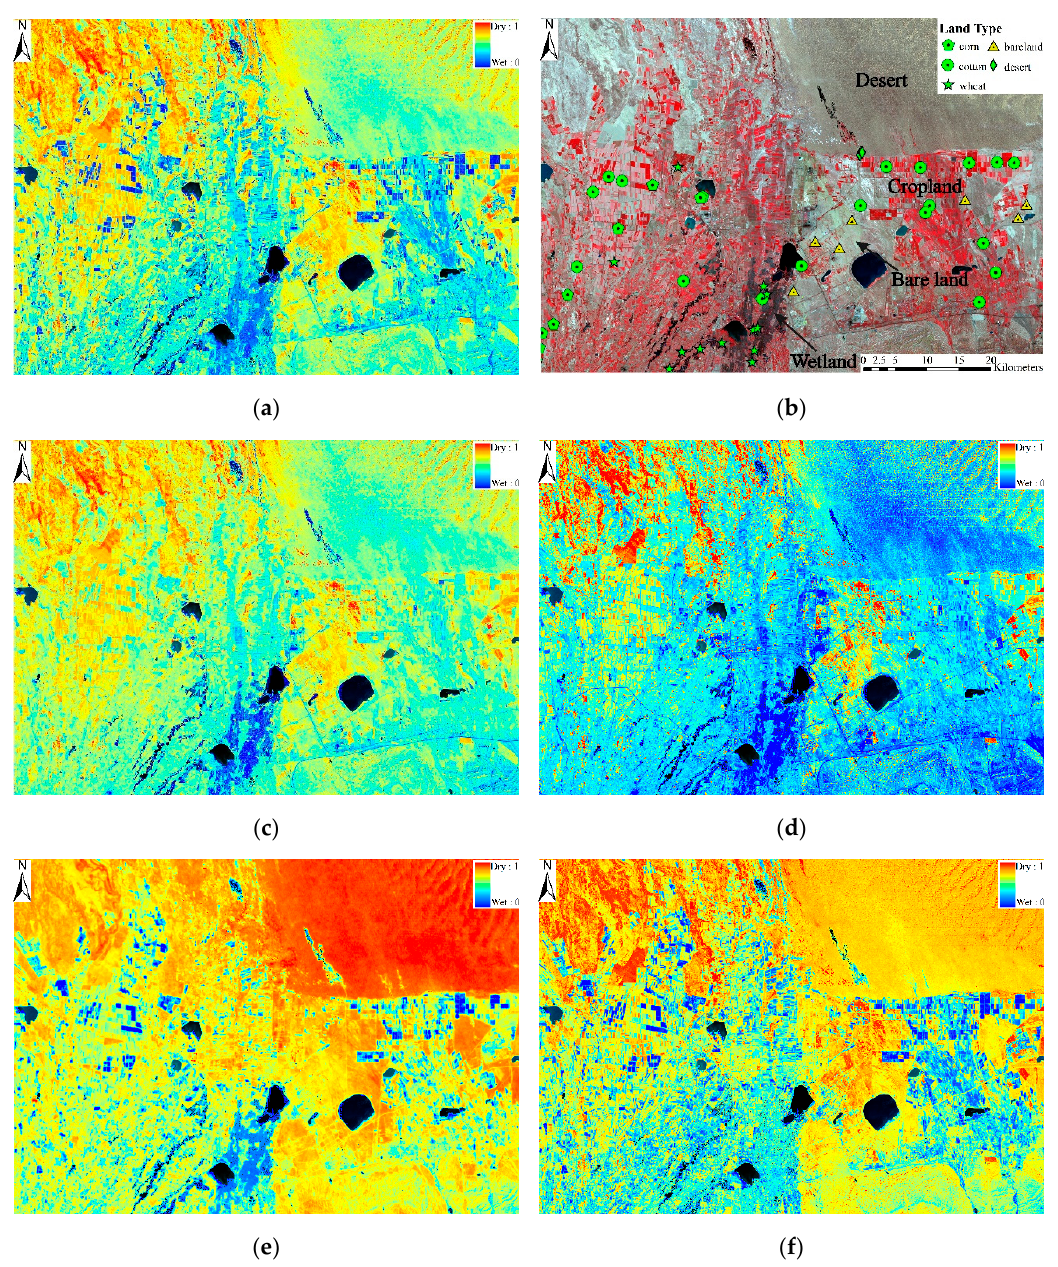
Figure 12. The dryness maps of the surrounding area of Fukang City using Landsat-8 imagery on the 12 June 2014. ( a ) RDMI, ( b ) the false color composite image, ( c ) PDI, ( d ) MPDI, ( e ) TVDI, and ( f ) TVMDI. (All the dryness values in these maps were normalized. The spatial resolution of these maps is 30 m).